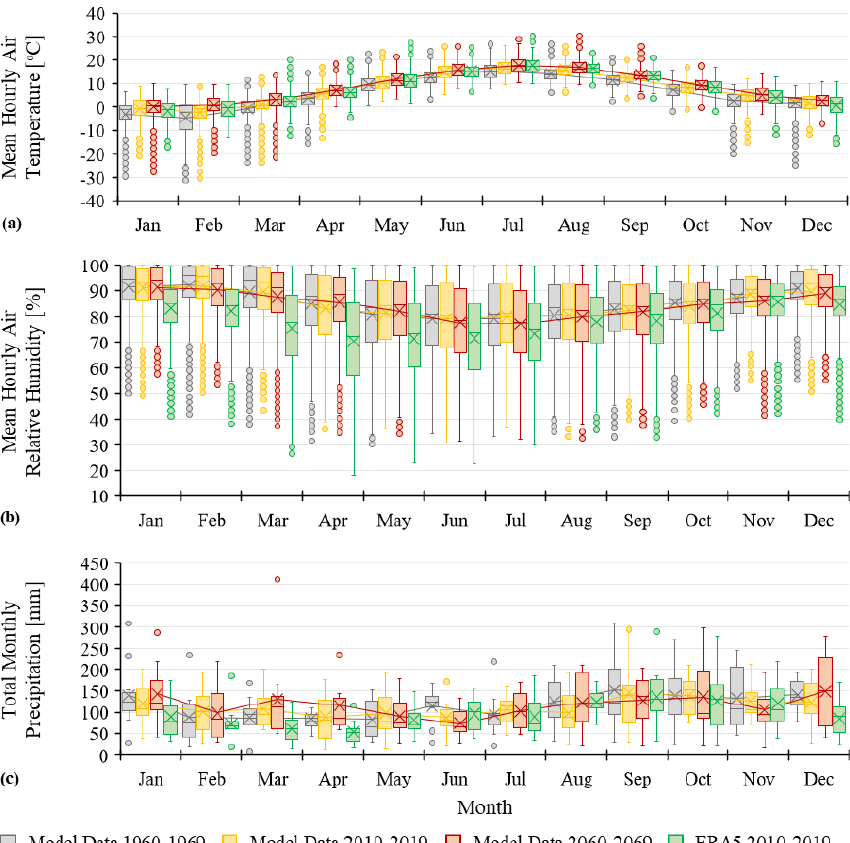
Figure 6. Comparison among (a) air temperature, (b) air relative humidity, and (c) precipitation data derived from the MPI-ESM- LR_REMO2015 model and ERA5. In the boxplots, the box shows 50% of the data, with the median represented as a horizontal bar and the average value highlighted with the “x” symbol. The whisker extends to two standard deviations of the data and the circles represent the